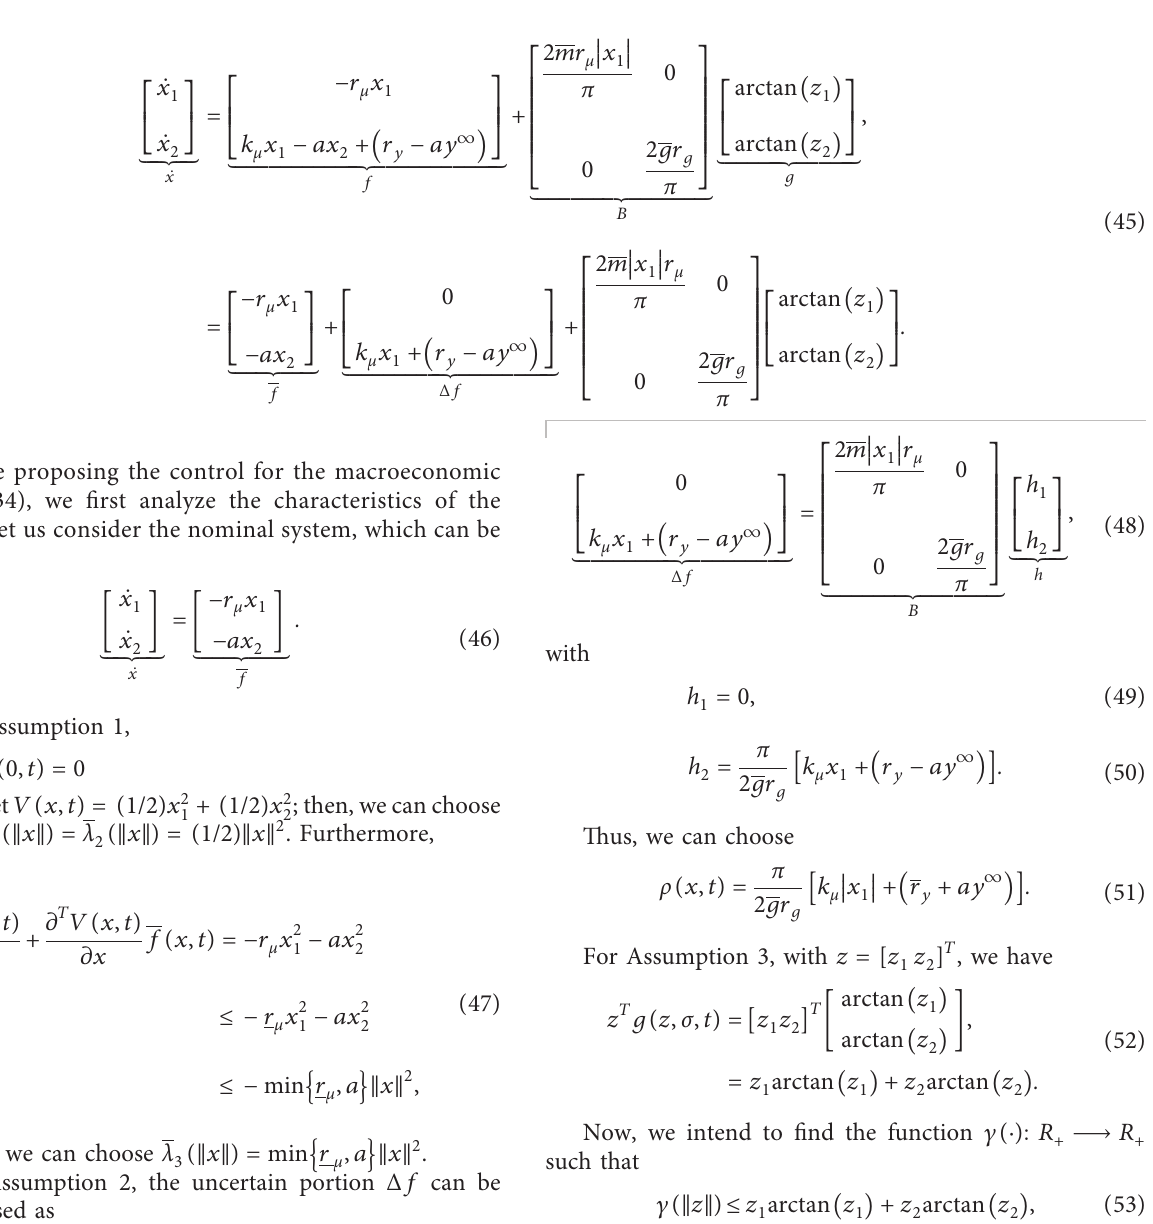
Figure 1: Mapping relationship of control variable